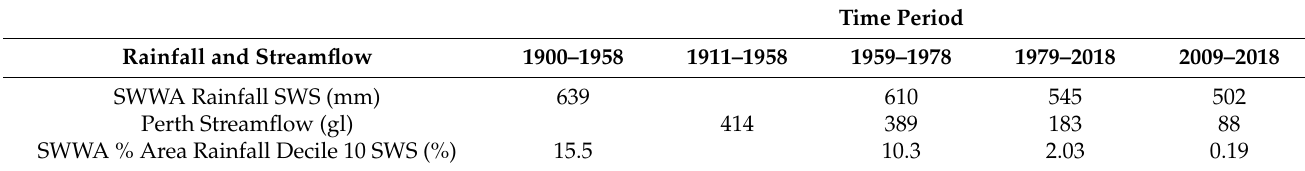
Table 1. The yearly mean SWWA rainfall in SWS, January to December streamflow into Perth dams and percentage area of SWWA with SWS rainfall in decile 10 (PAR D10 ) for different time periods.